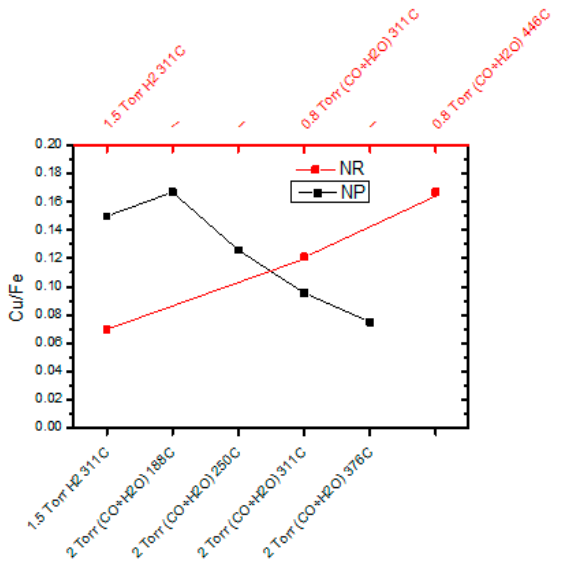
Figure 8. Atomic fraction of Cu/Fe of the Cu 1 Fe 9 O x catalyst under WGS reaction conditions, NR: nanorod sample, NP: nanoparticle sample.